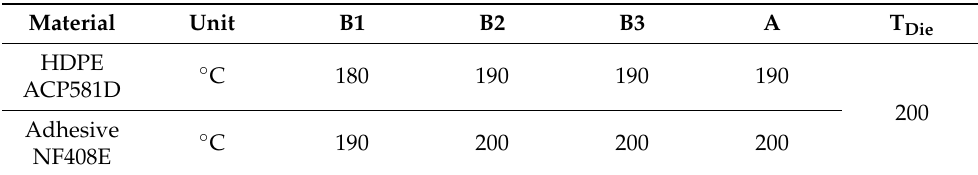
Table 4. Barrel, adapter, and die temperatures.